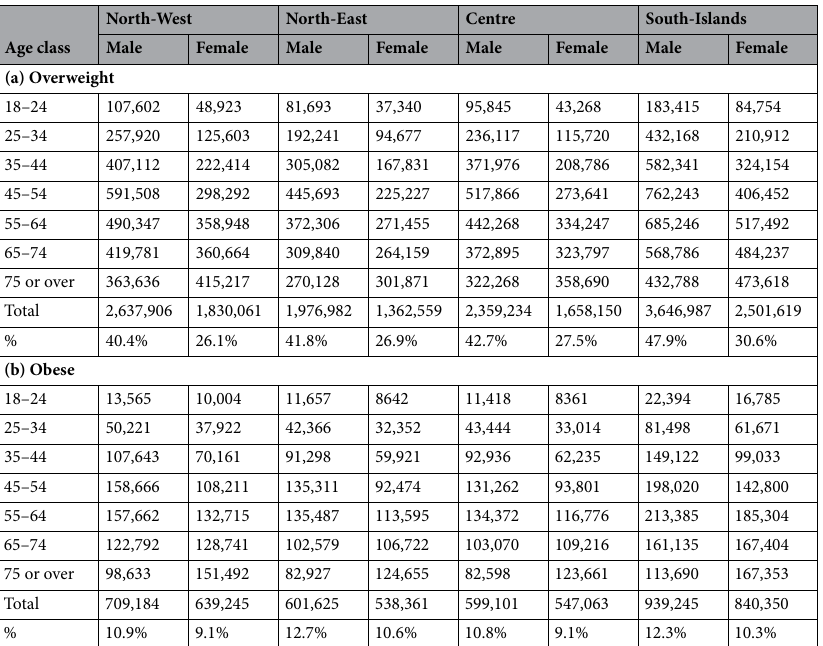
Table 3. Number of overweight (a) and obese (b) people in Italy by gender and macro-regions, based on ISTAT (2019). Data is expressed in number of persons.